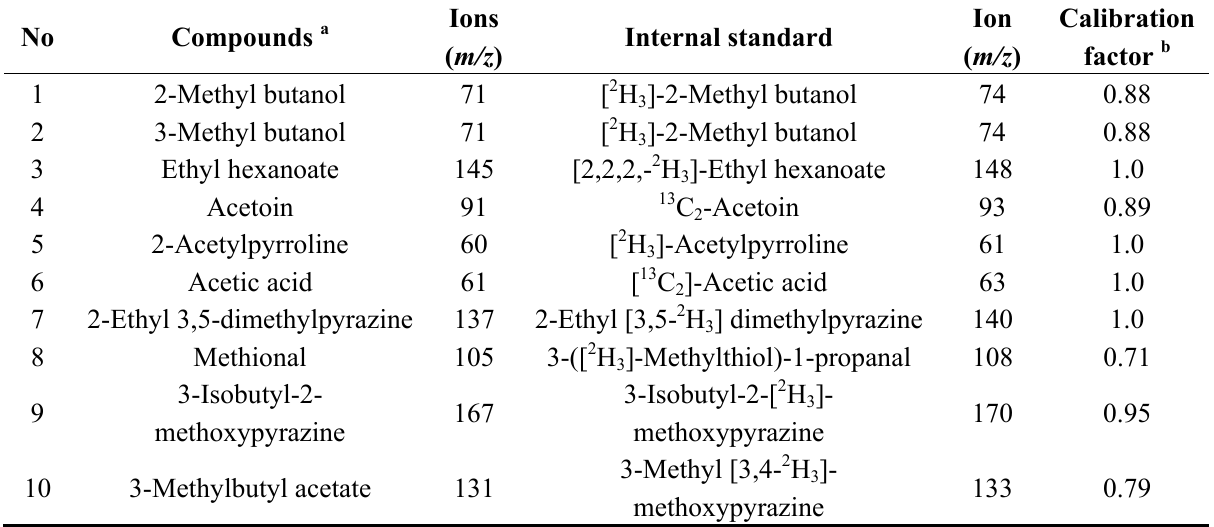
Table 3. Selected ions and calibration factors used for quantitation by stable isotope dilution assay